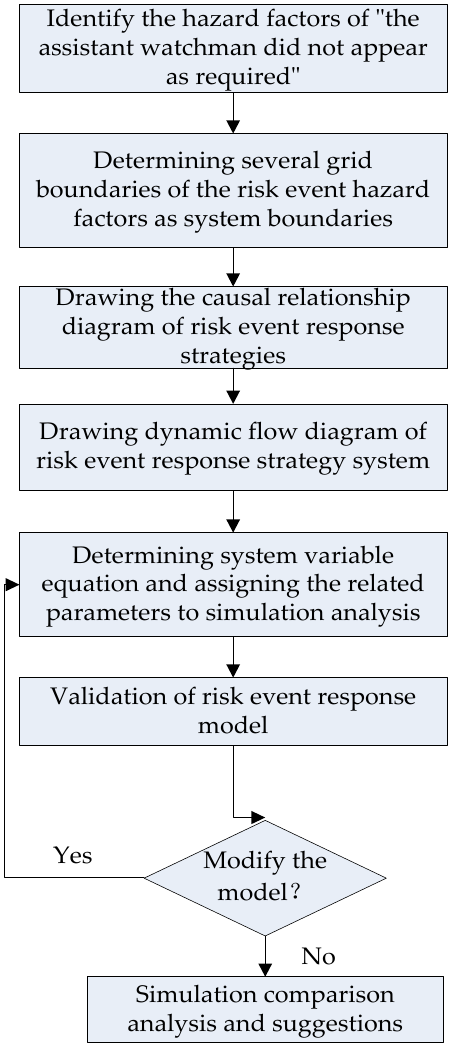
Figure 5. The grid response framework of G H